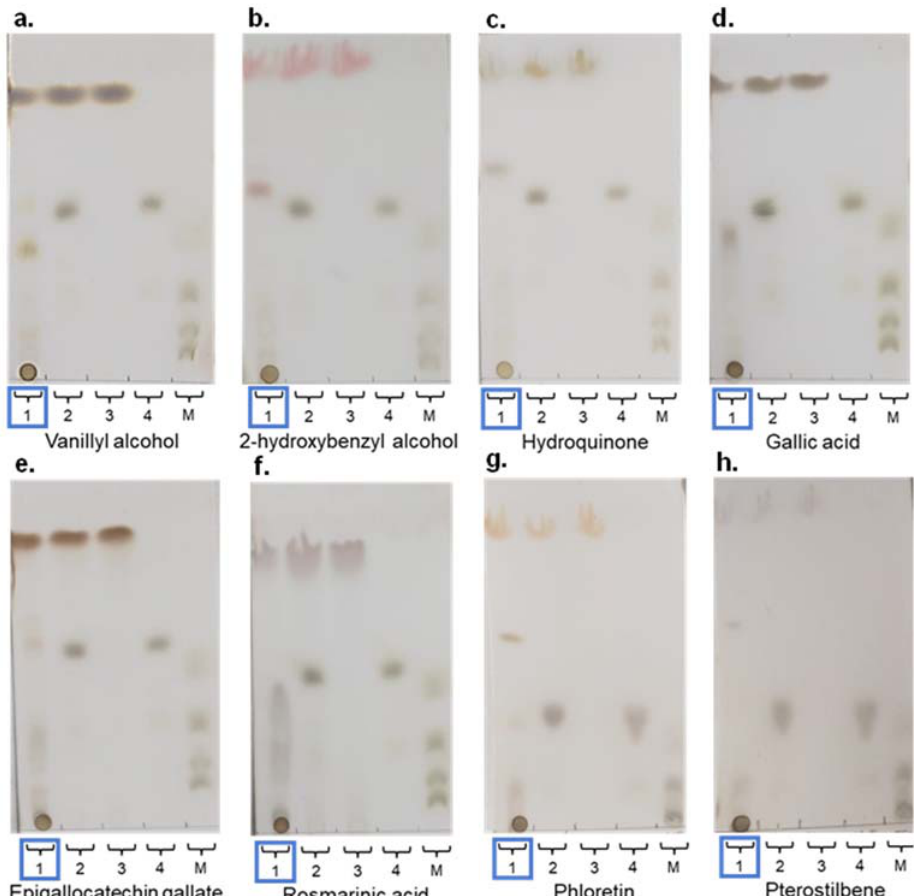
Figure 5. Thin layer chromatography (TLC) analysis of glycosylation reactions catalyzed by rXynSOS- E236G, using 20 mM X 2 F as donor and different acceptor molecules at 20 mM: ( a ) vanillyl alcohol; ( b ) 2-hydroxybenzyl alcohol; ( c ) hydroquinone; ( d ) gallic acid; ( e ) epigallocatechin gallate (EGCG); ( f ) rosmarinic acid; ( g ) phloretin; and ( h ) pterostilbene. Lane 1 (highlighted with a blue rectangle): samples of glycosylation mixtures containing the acceptor indicated in every case, X 2 F as xylobiose donor, the catalyst, and the reaction products. Lane 2: negative control with acceptor and X 2 F and no catalyst. Lane 3: negative control containing only the acceptor molecule. Lane 4: negative control containing only the donor X 2 F. Lane 5. Standards mixture with xylose, xylobiose, xylotriose, and xylotetraose. Table 3. Synthesis of glycosides by the glycosynthase variant rXynSOS ‐ E236G using 20 mM X 2 F as xylobiose donor and different acceptor molecules at 20 mM. Glycosides were detected by ESI ‐ MS in the positive mode as Na ‐ adducts. The yield of the main glycoside of each reaction was calculated by HPLC.